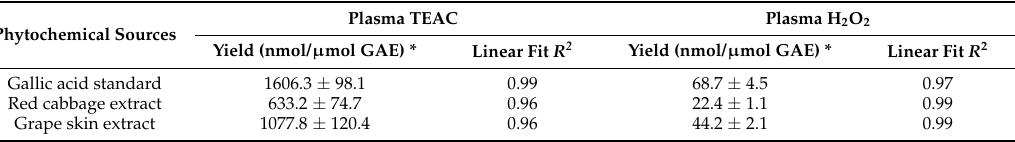
Table 1. Effects of plant extracts on plasma Trolox equivalent antioxidant capacity (TEAC) and plasma levels of hydrogen peroxide (H 2 O 2 ) in vitro.